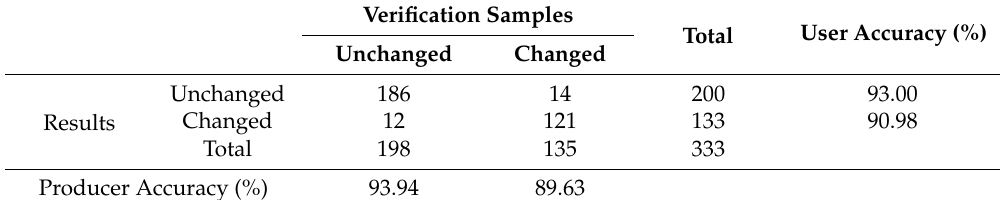
Table 8. Confusion matrix of ODCD.